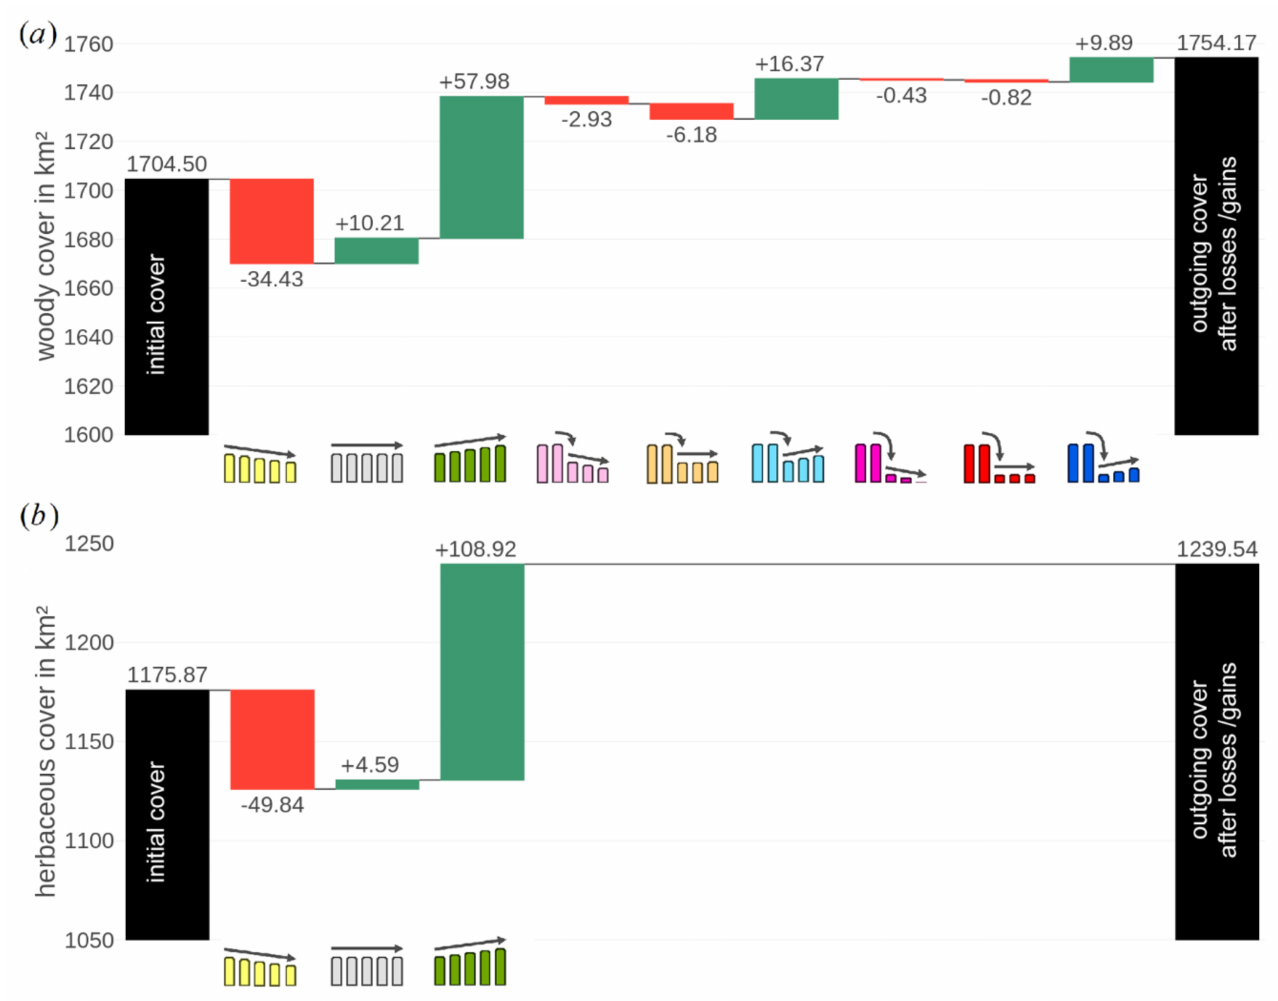
Figure 11. Vegetation cover bookkeeping for all semi-natural areas in Crete. ( a ) Woody vegetation; ( b ) herbaceous vegetation. The gains/losses of the individual vegetation dynamics syndromes are subsequently booked on the initial vegetation cover (1984), thus resulting in the outgoing vegetation cover